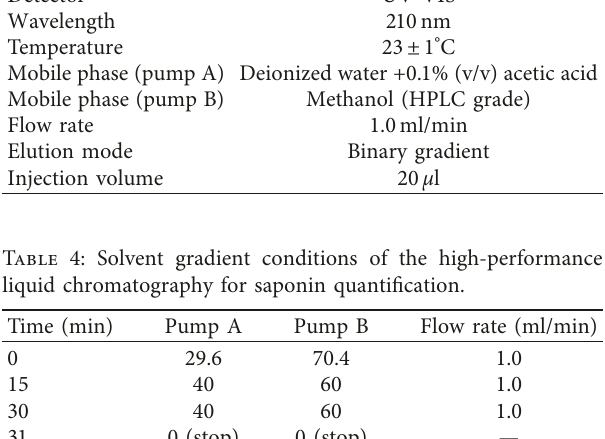
Figure 3: Linear relationship between time/concentration of sa- ponins (min/mg) with respect to extraction time (min). a–e: dif- ferent alphabets indicate a significant difference ( p